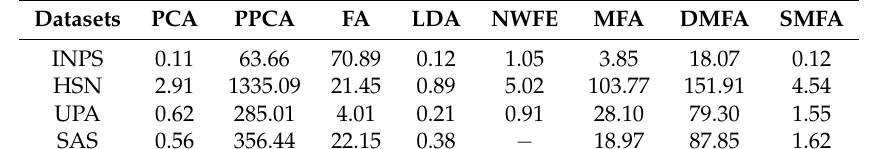
Table 6. CPU processing times in seconds by different DR methods applied to the Indian Pines (INPS), Houston (HSN), University of Pavia (UPA), and Salinas (SAS) datasets (the number of features = 20).